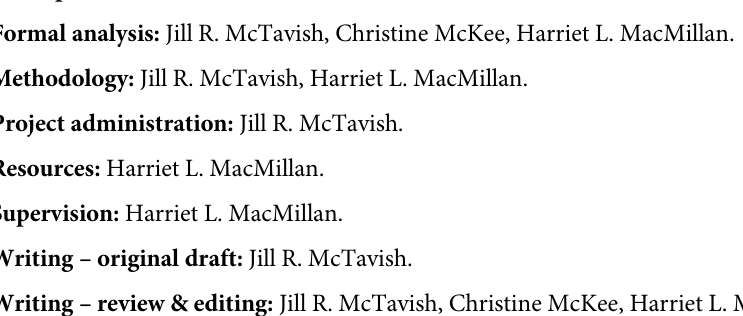
S1 Table. PRISMA and ENTREQ checklists. S2 Table. Modified CASP critical appraisal form. S3 Table. Participant and study characteristics. S4 Table. Facets of participation. S5 Table. Facilitators and barriers of foster children’s